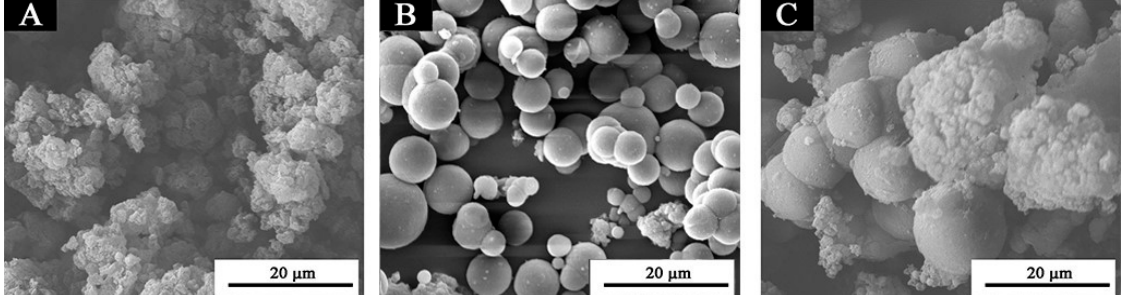
Figure 5. SEM images of microcapsules with different ratios of core materials to shell material in mass. ( A ) the ratio of core materials to shell material in mass of 0.55, ( B ) the ratio of core materials to shell material in mass of 0.65, and ( C ) the ratio of core materials to shell material in mass of 0.75.